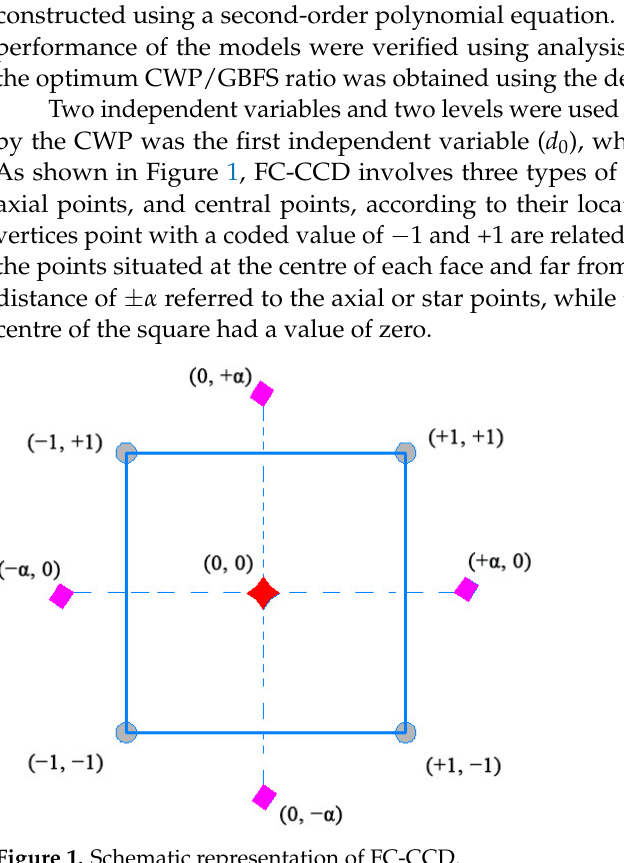
Figure 1. Schematic representation of FC-CCD.